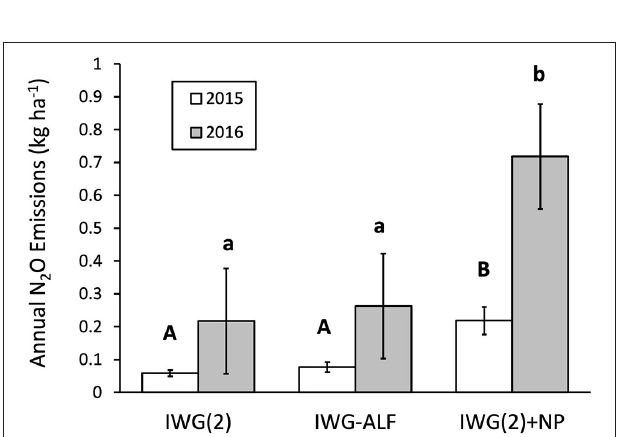
FIGURE 8 | N 2 O emissions summed over growing season in 2015 and 2016 from IWG(2), IWG-ALF, and IWG(2) + NP treatments. Treatments with different letters indicate significant differences at p < 0.05 (Tukey HSD). Bars = 1S.E.